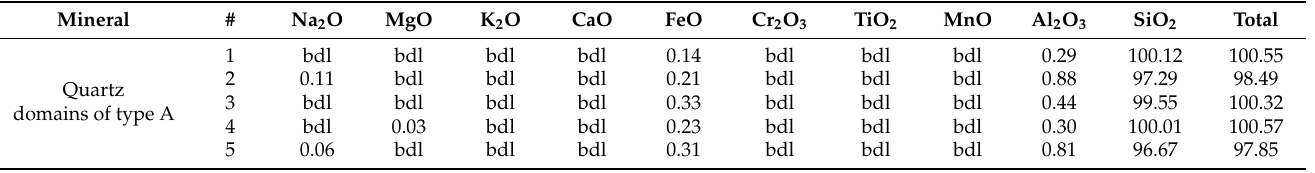
Table 1. Chemical composition of ballen quartz in domains A and B and cristobalite in the rim of ballen quartz, as determined by